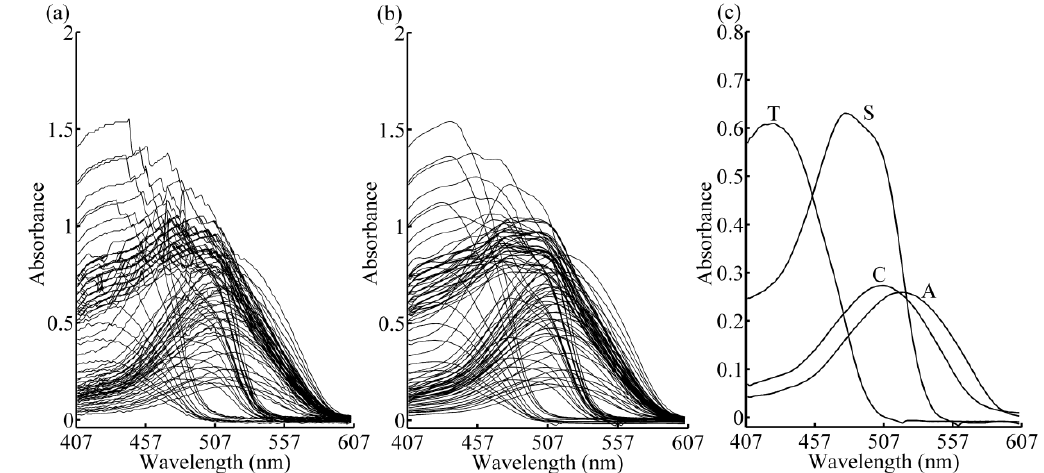
Figure 1. Raw absorption spectra ( a ), filtered spectra with Savitzky-Golay smoothing ( b ), and pure component spectra ( c ) of food coloring samples. A: amaranth; C: carmine; T: tartrazine; S: sunset yellow FCF.